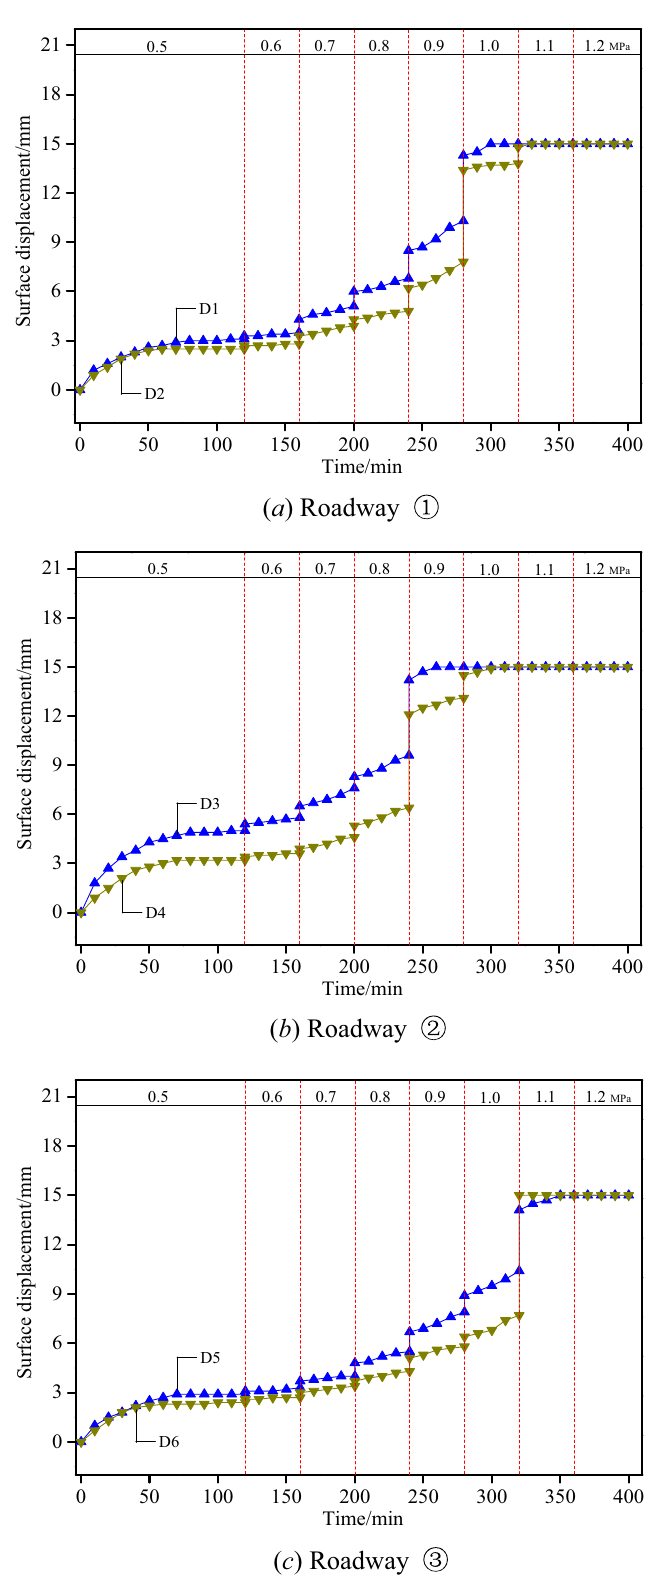
Figure 16. Surface displacement variation curves of roofs and walls of various